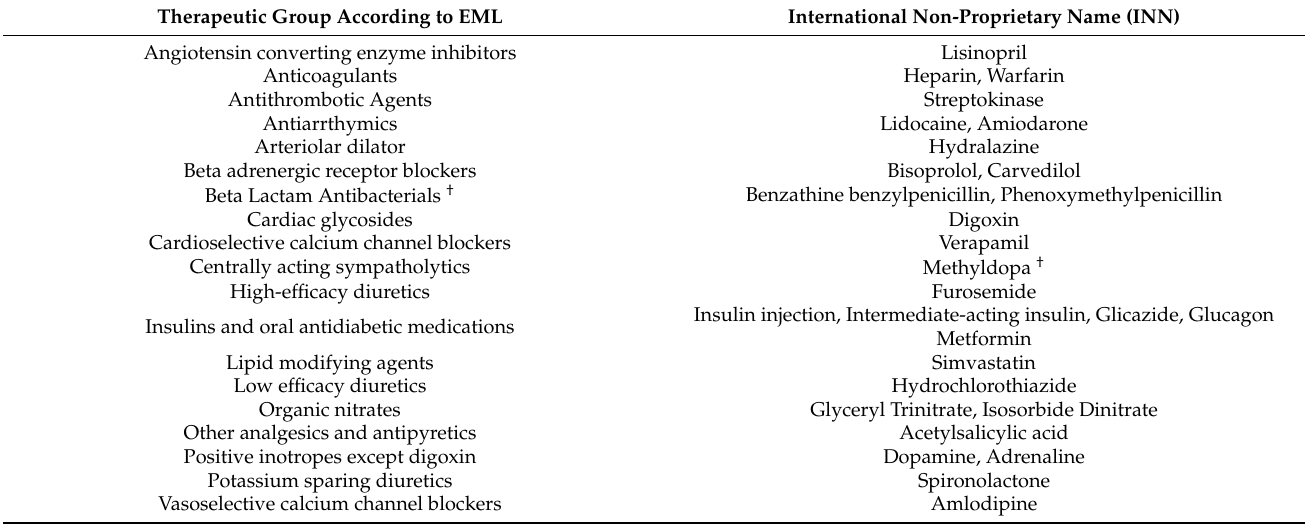
Table 1. List of drugs included in the WHO Model List of Essential Medicines (EML). Therapeutic Group According to